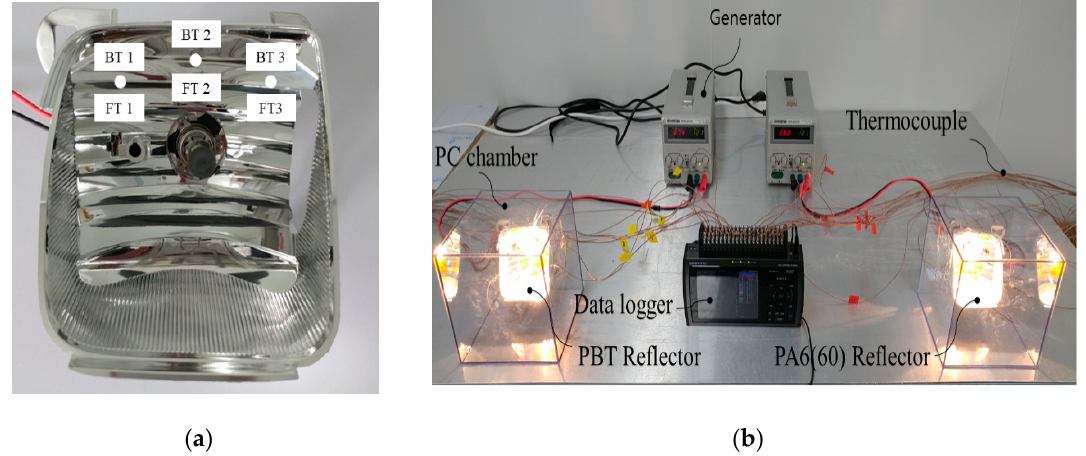
Figure 6. Experimental setup for reflector temperature measurement, ( a ) reflector temperature measurement positions; ( b ) device setup.